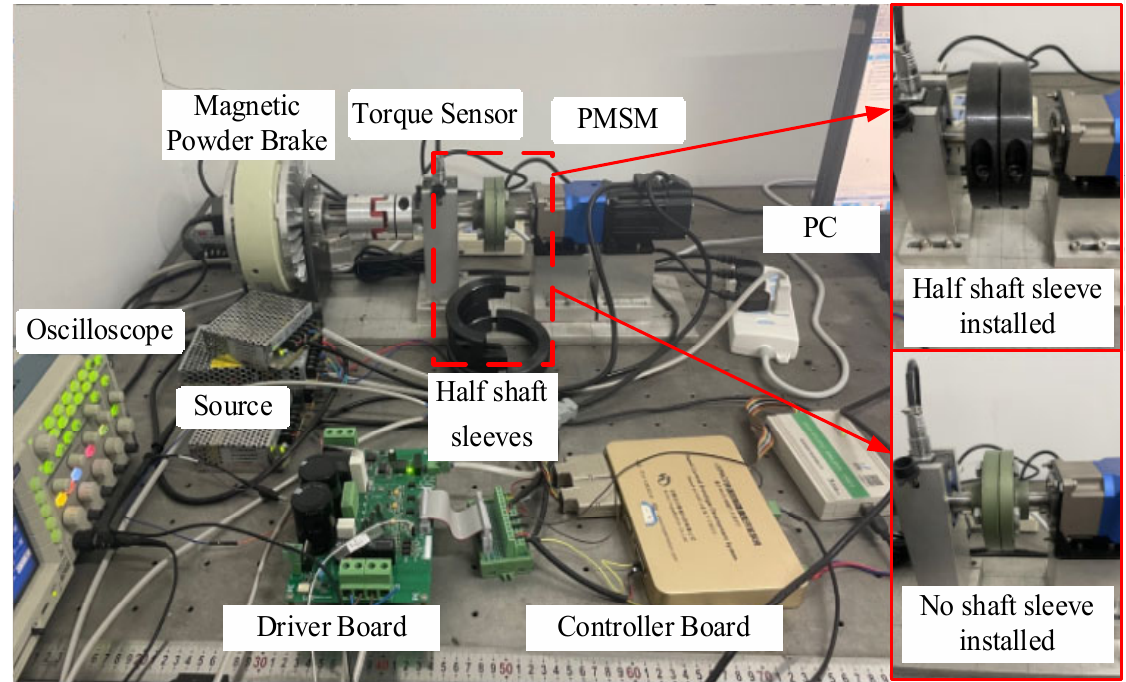
Figure 8. Experiment platform. Table 5. Parameters of the PMSM.